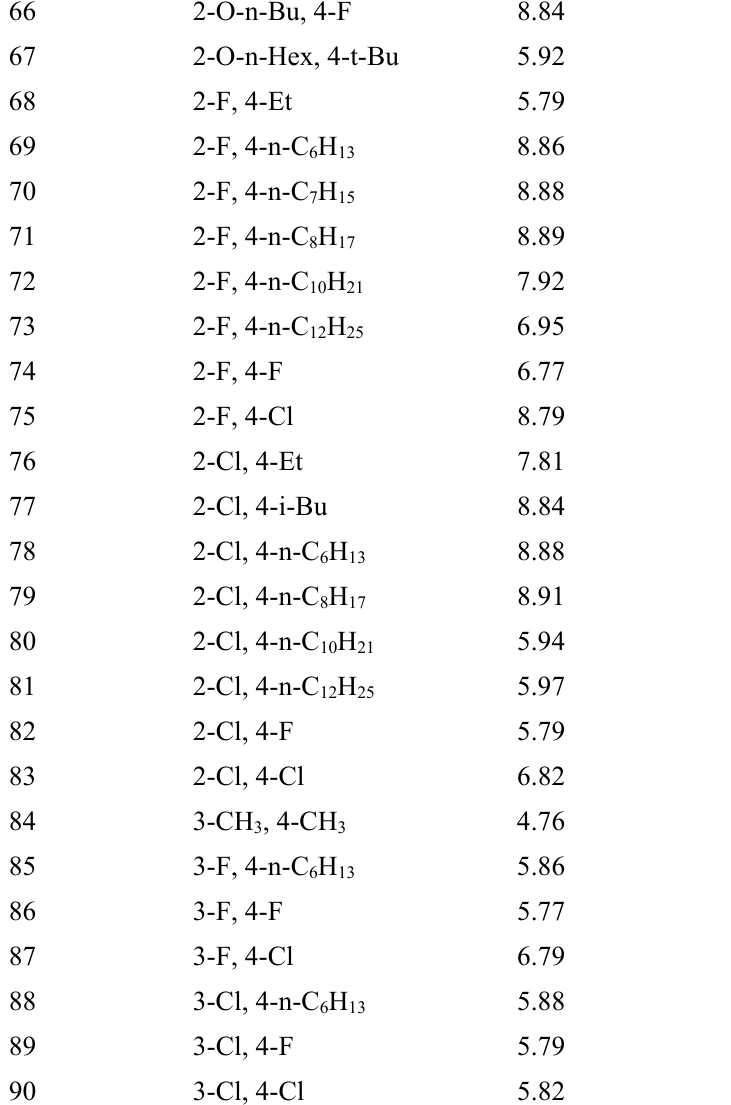
Table 3. Toxicity (-log IGC